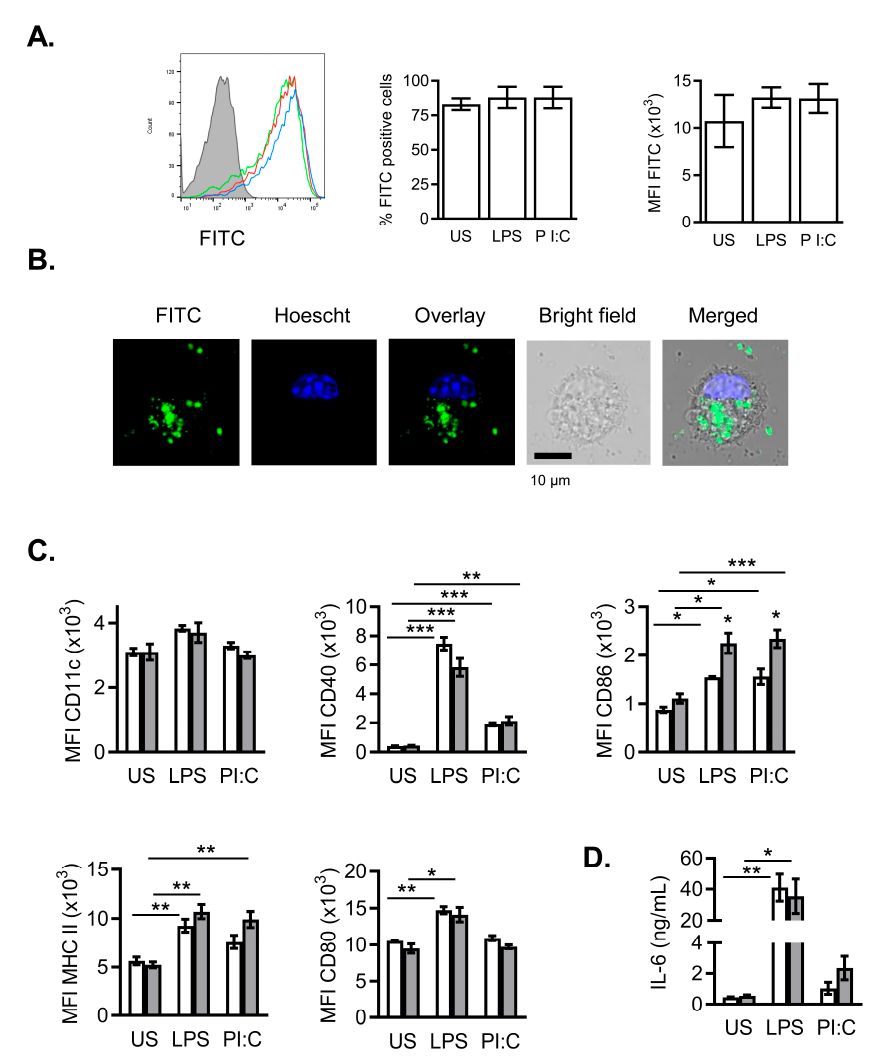
Figure 6. Incorporation of FITC-NanoMBGs by bone marrow-derived dendritic cells (BMDCs). ( A ) Incorporation of nanospheres (histogram and graphs) into BMDCs with di ff erent stimuli during 24 h. Cytometry analysis (percentage of positive cells and median of fluorescence intensity, MFI) of BMDCs treated with FITC-NanoMBGs plus di ff erent stimuli such as LPS (red) or Poly I:C (PI:C, blue) or unstimulated cells (green, US) are shown. BMDCs in the absence of nanospheres are depicted in grey. ( B ) Confocal microscopy analysis of FITC-NanoMBGs incorporation into BMDCs after 2 h of incubation. Images of a representative 0.772 μ m slice are shown. Panels (from left to right) show FITC-nanomaterial (green), cell nucleus stained with Hoescht (blue) and the overlay of both. Bright field image of the cell and the merged images are also shown. ( C ) BMDCs were activated as in (A) in the presence (grey bars) or absence (white bars) of NanoMBGs, and the expression of di ff erent surface markers (CD11c, CD40, CD80, CD86 and Class-II Major Histocompatibility Complex molecules (MHC II)) was analyzed by flow cytometry (median fluorescence intensity, MFI). ( D ) IL-6 production measured by ELISA in 24 h culture supernatants of BMDCs with (grey bars) or without (white bars) the NanoMBGs and the indicated stimuli. Data (mean ± SEM) from one representative experiment out of three, each with triplicates, are shown. Asterisks indicate significant di ff erence when activated vs. non-activated cells are compared. * p < 0.05; ** p < 0.01; *** p <